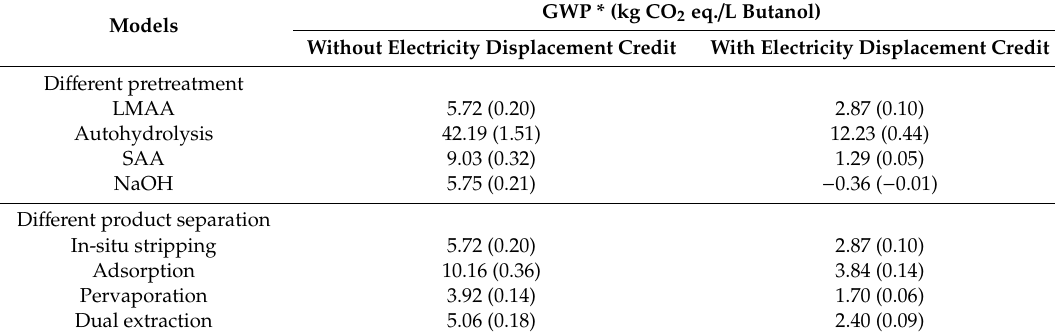
Table 8. Global warming potentials (GWP) of simulated cellulosic butanol production plants.